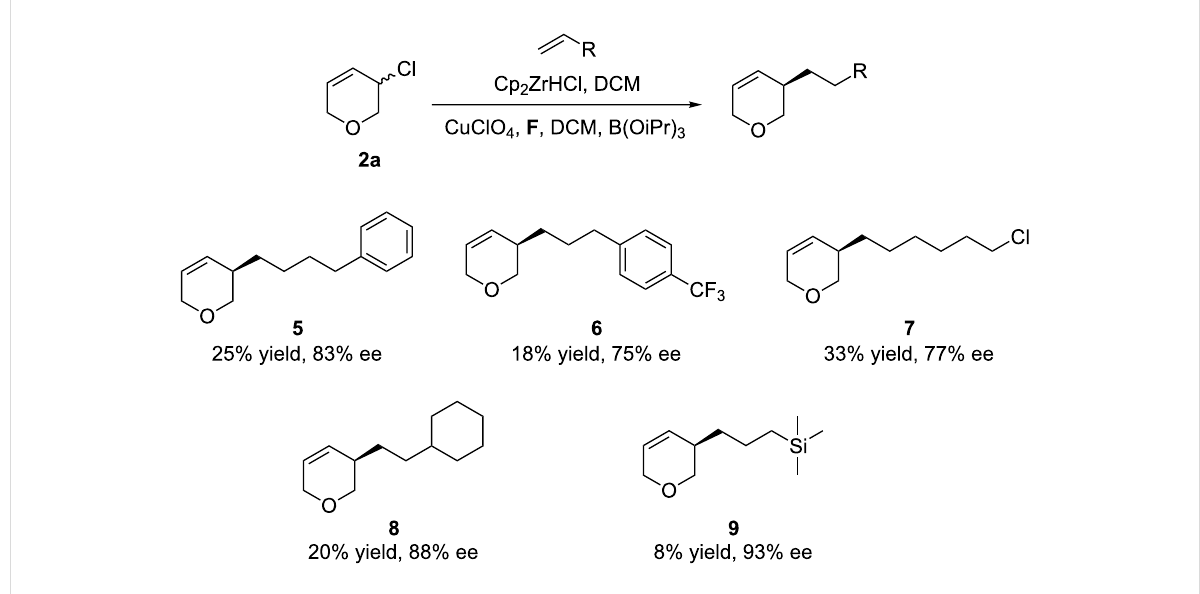
Figure 2: Reaction kinetics as monitored by in situ 1 H NMR spectroscopy from 3-chloro-3,6-dihydro-2 H -pyran ( 2a ).